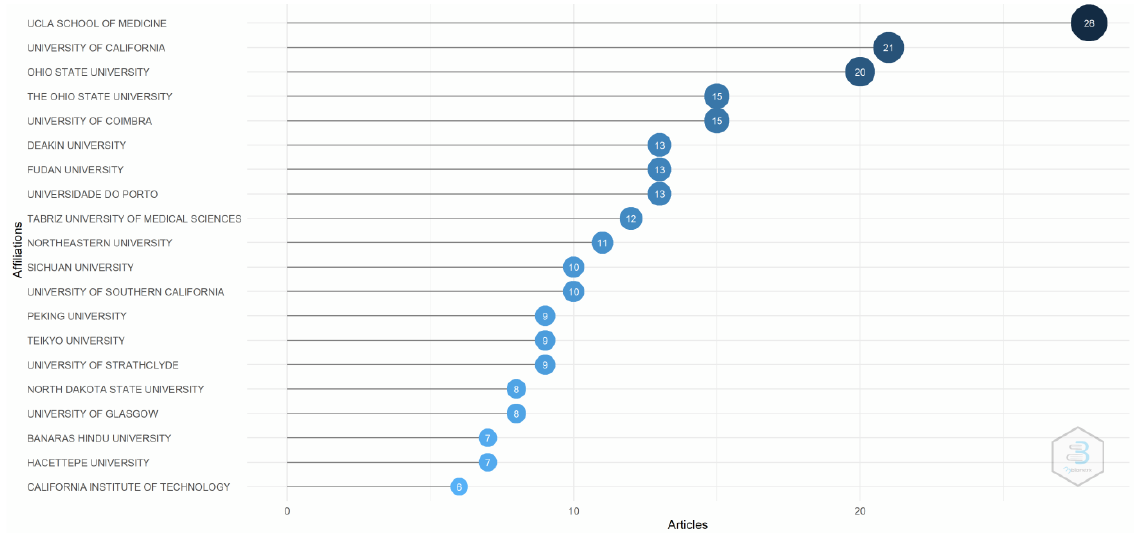
Figure 4. Most relevant affiliations. Source: Authors’ elaboration using the Bibliometrix R-package.